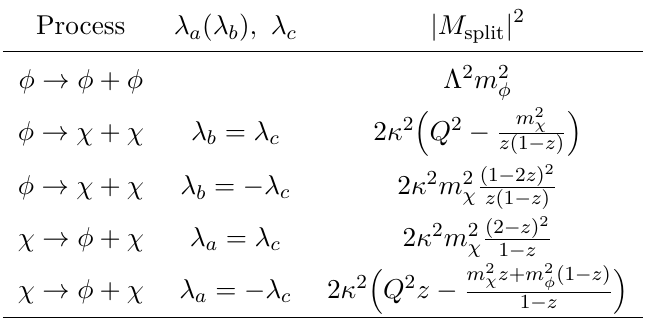
Table 1 . The | M split | 2 for each splitting in the singlet sector of the NMSSM. The fermion helicity is labelled by λ